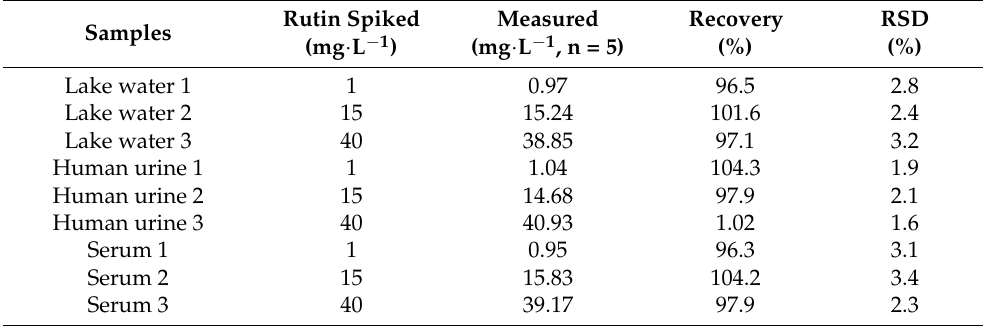
Table 3. Results of the rutin recoveries in lake water, human urine, and serum samples.